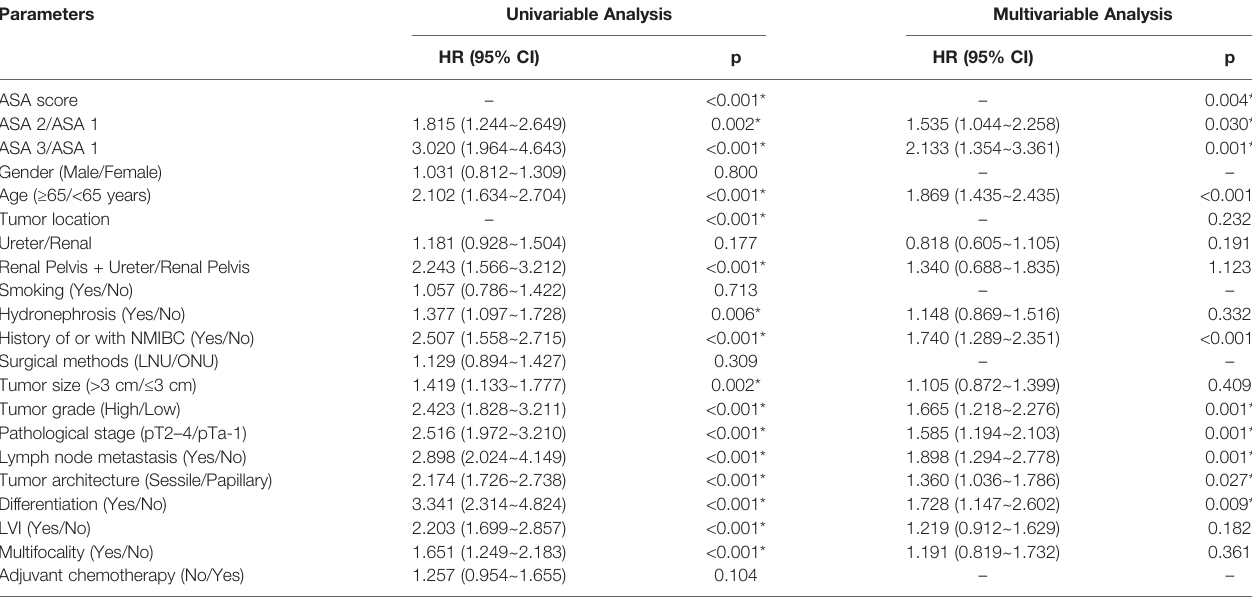
ASA,American Society of Anesthesiologists; HR,hazard ratio; LNU,laparoscopic nephroureterectomy; LVI,lymphovascularinvasion; NMIBC,non-muscle invasive bladder cancer; ONU, open nephroureterectomy; OS, overall survival. *p < 0.05.